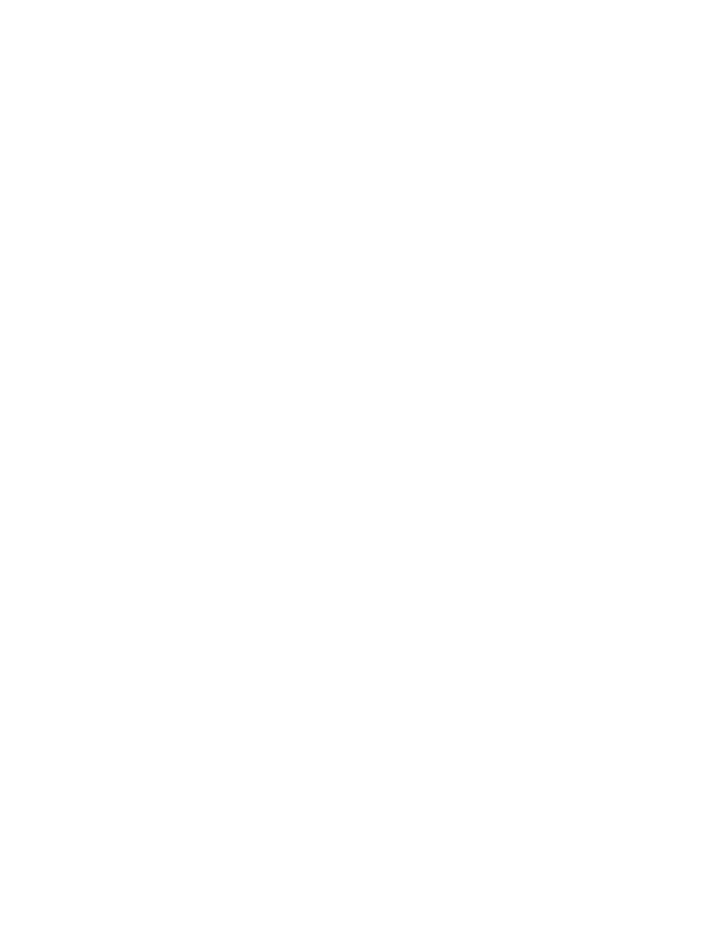

In vitro therapeutic efficiency of KXS on Aβ25-35-induced PC12 cells. KXS significantly promoted the cell viability of PC12 compared with those treated with PR and/or PO and/or AT combined with the administering of the GR herb (a). Treatment with KXS resulted in the inhibition of inflammation revealed by an alleviation of TNF-α (b) and IL-1β (c). Detection of ROS reduction in PC12 cells treated with KXS (d). Morphological examination of Tubulin in PC12 cells treated with KXS and PR and/or PO and/or AT combined with the administering of the GR herb (e and f). The column diagrams marked by different letters were significant to each other at the 0.05 level according to Duncan's multiple range test. Values were mean ± SE (n = 6), scale bar = 20 μm.